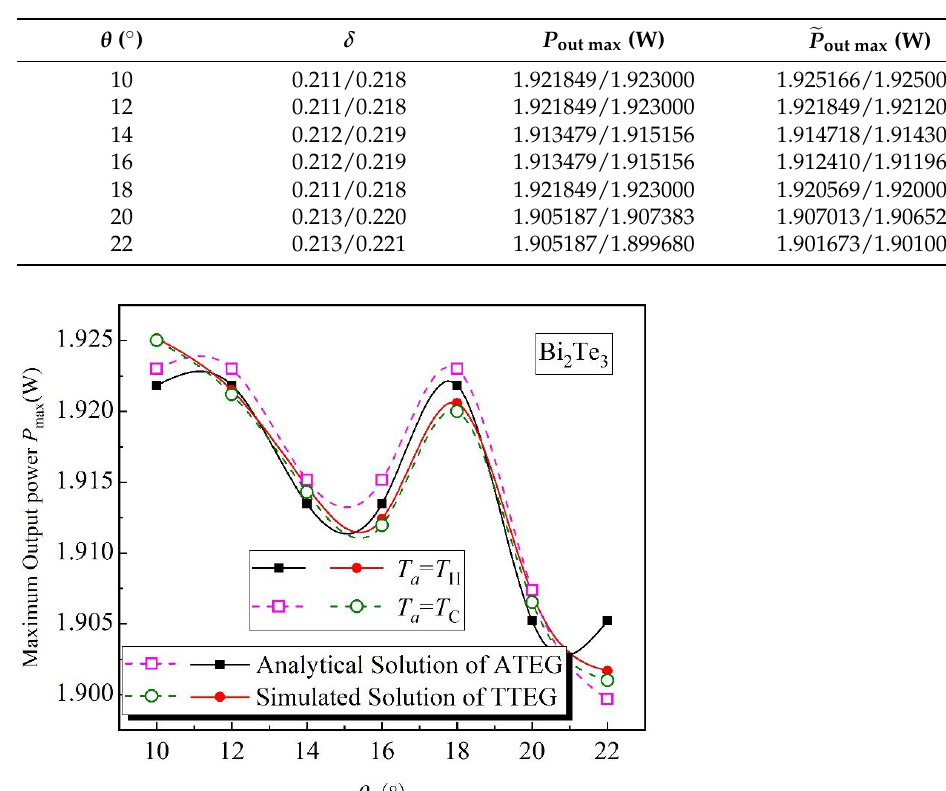
Figure 8. Relative error of explicit analytical and simulated solution after different angles of θ . Finally, for a low temperature equal to 300 K and a high temperature at the a sides (450 K – 530 K), when θ = 10°, we calculate the maximum output power versus high tem- perature with different thermoelectric materials, as shown in Figure 9. As the temperature at the hot end increases, the output power peak increases. When the δ reaches the optimal value, the explicit analytical solution is highly consistent with the simulated solution re- gardless of Bi 2 Te 3 material or PbTe material. When the temperature at the hot end is 450 K, 470 K, 490 K, 510 K, and 530 K, for the maximum output power of Bi 2 Te 3 material, the explicit analytical solution of the ATEG is 1.9218, 1.6782, 1.4432, 1.2108, and 0.9890 W, and the simulated solution of TTEG is 1.9252, 1.6786, 1.4401, 1.2126, and 0.9910 W. For the maximum output of PbTe material, the explicit analytical solution of the ATEG is 2.7235, 1.9799, 1.3884, 0.9302, and 0.5990 W, and the simulated solution of the TTEG is 2.7206, 1.9814, 1.3870, 0.9316, and 0.5991 W. A low temperature at the hot end can lead to a low maximum output power. Based on the above content, we can know that the explicit analytical solution of the ATEG can clarify the influence of various material parameters on the performance of the device and avoid traversal calculations, but the solving process is relatively complex. The